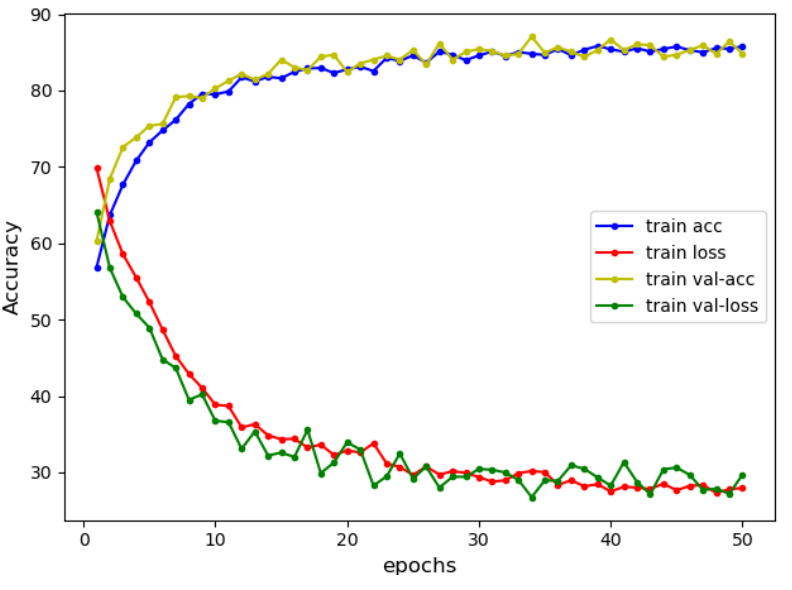
Figure 10. CBGRU training process.